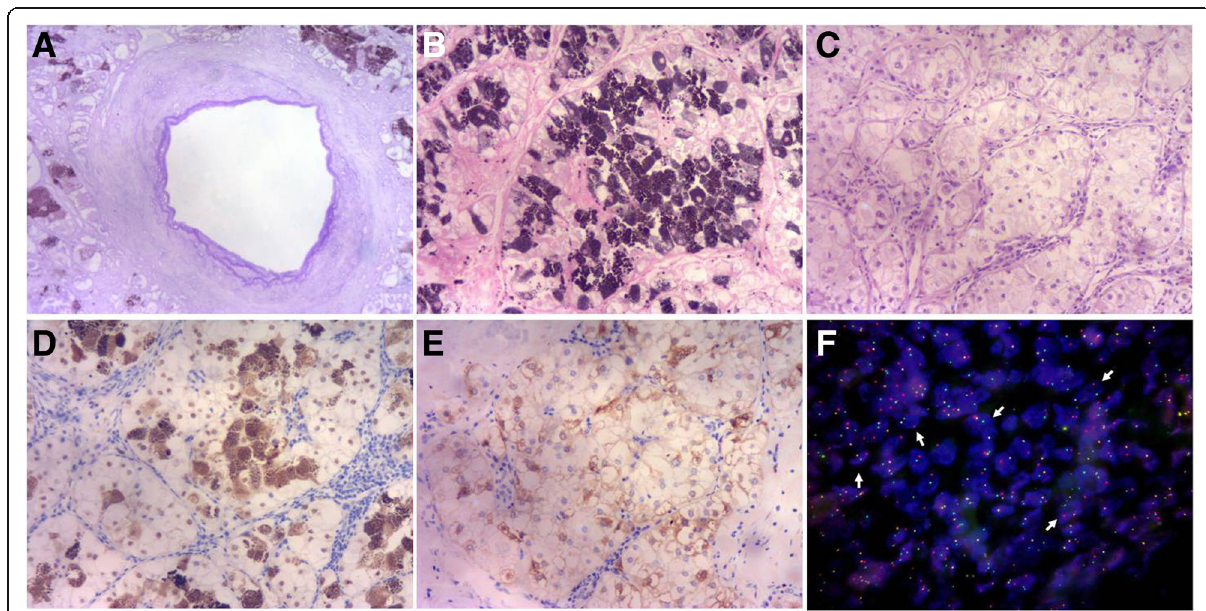
Fig. 3 a The elastic fibers of thick-walled blood vessels are highlighted by Gomrori ’ s aldehyde-fuchsin staining (× 100). The cytoplasmic pigment is positive for Fontana-Masson staining ( b ) (× 100); it was removed by potassium permanganate bleaching ( c ) (× 100). Tumor cells exhibit diffuse nuclear immunoreactivity for TFE3 ( d ) (IHC staining, × 100) and patchy cytoplasmic positivity for HMB45 ( e ) (IHC staining, × 100). f Break-apart FISH for TFE3 produced normal fused signals and split signals (arrows); one pair of each type of signal is depicted (×